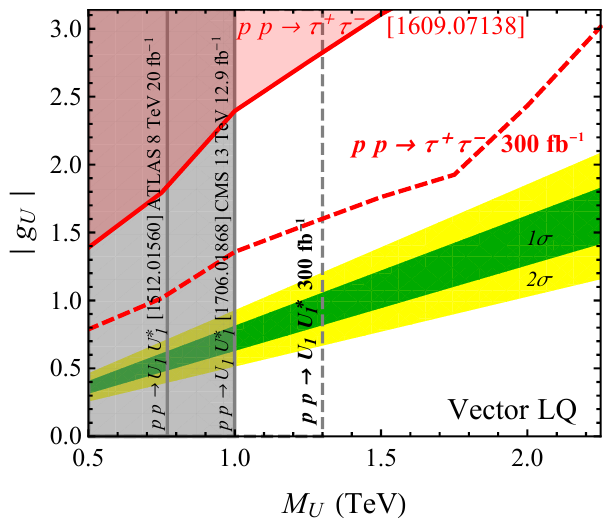
Figure 5 . Present and future-projected LHC constraints on the vector leptoquark model of section 3.1. The 1 (cid:27) and 2 (cid:27) preferred regions from the low-energy (cid:12)t are shown in green and yellow,